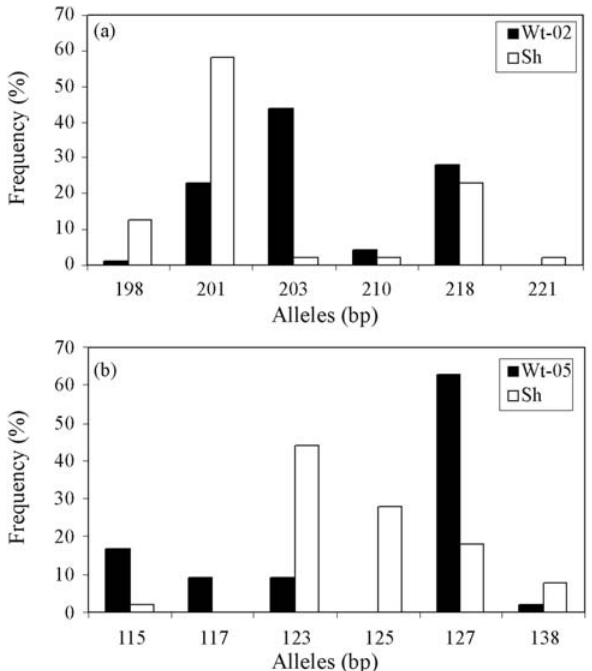
Figure 2 - Allelic frequency distributions in the markers One3ASC (a) and One19ASC (b) linked to spawning time QTLs in Wytheville 02 (Wt-02), Wytheville 05 (Wt-05) and Steelhead (Sh) stocks.